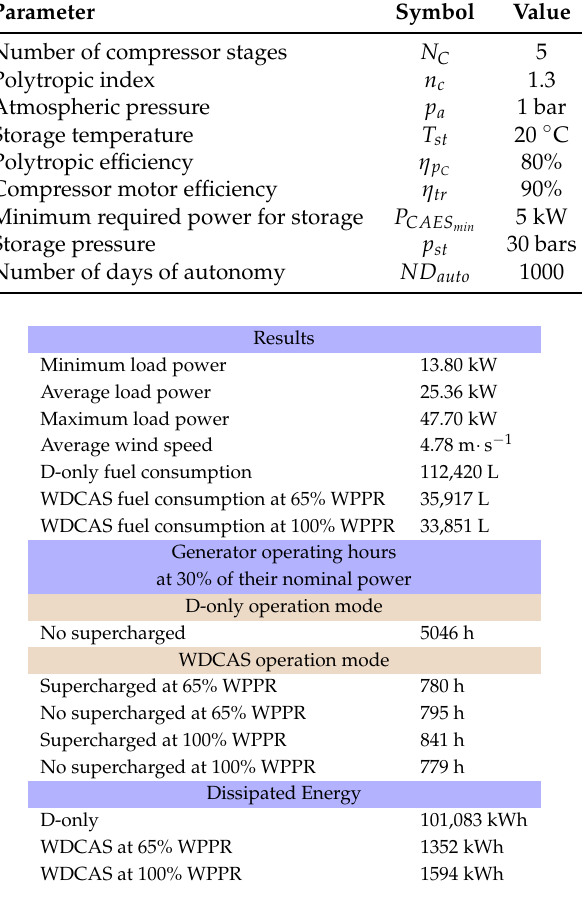
Figure 4. WDCAS software results at 65% and 100% wind power penetration rate